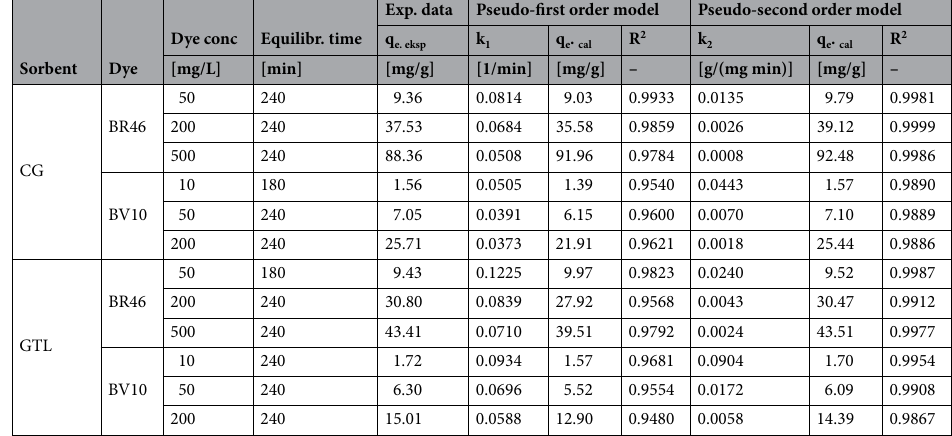
Table 2. Kinetic parameters of BR46 and BV10 sorption onto CG and GTL determined from the pseudo-first order model and pseudo-second order model.